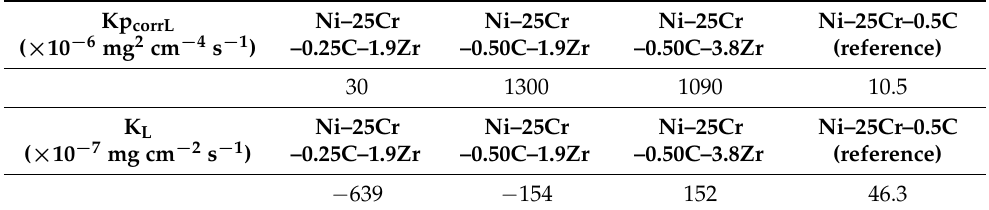
Table 6. The values of the oxidation parabolic constants Kp determined by taking into account a part of linear mass gain (and value of the linear constant K L ) for the three Zr–containing alloys; comparison with the reference ternary